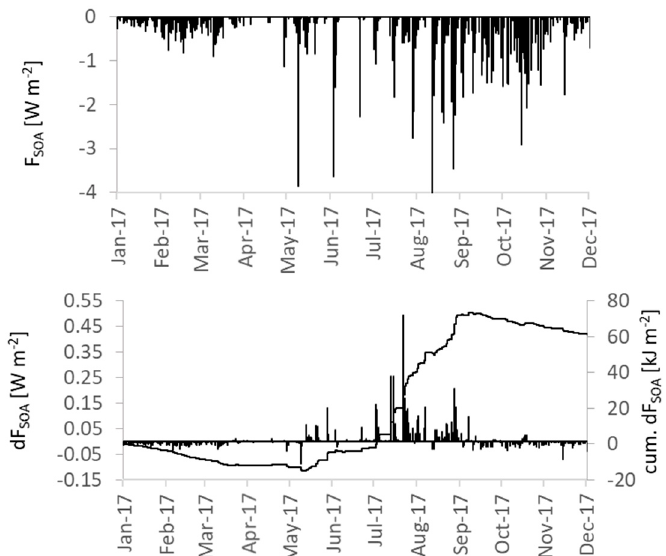
Figure 8. Approximated direct radiation effect of secondary organic aerosols ( F SOA ) for remote Black Forest conditions during 2017. Upper panel: Pattern of F SOA during 2017; bottom panel: Difference between pure beech and a 50% beech/fir mixture in W m − 2 (left axis) and the cumulative change for 50% fir admixture (broken line).